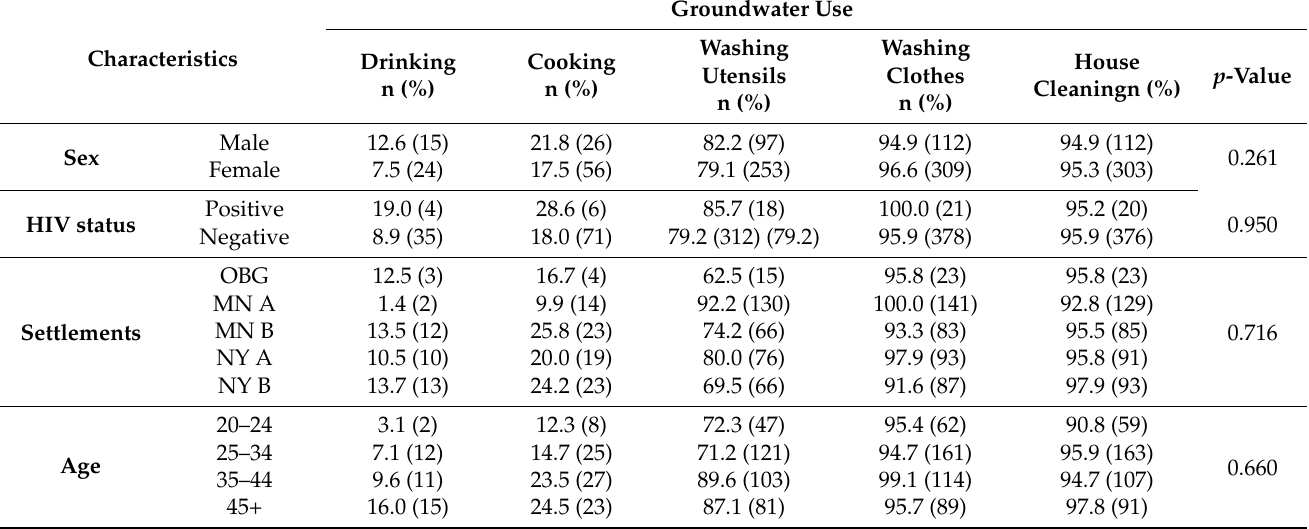
Table 5. Percentage distribution of groundwater use against sociodemographic